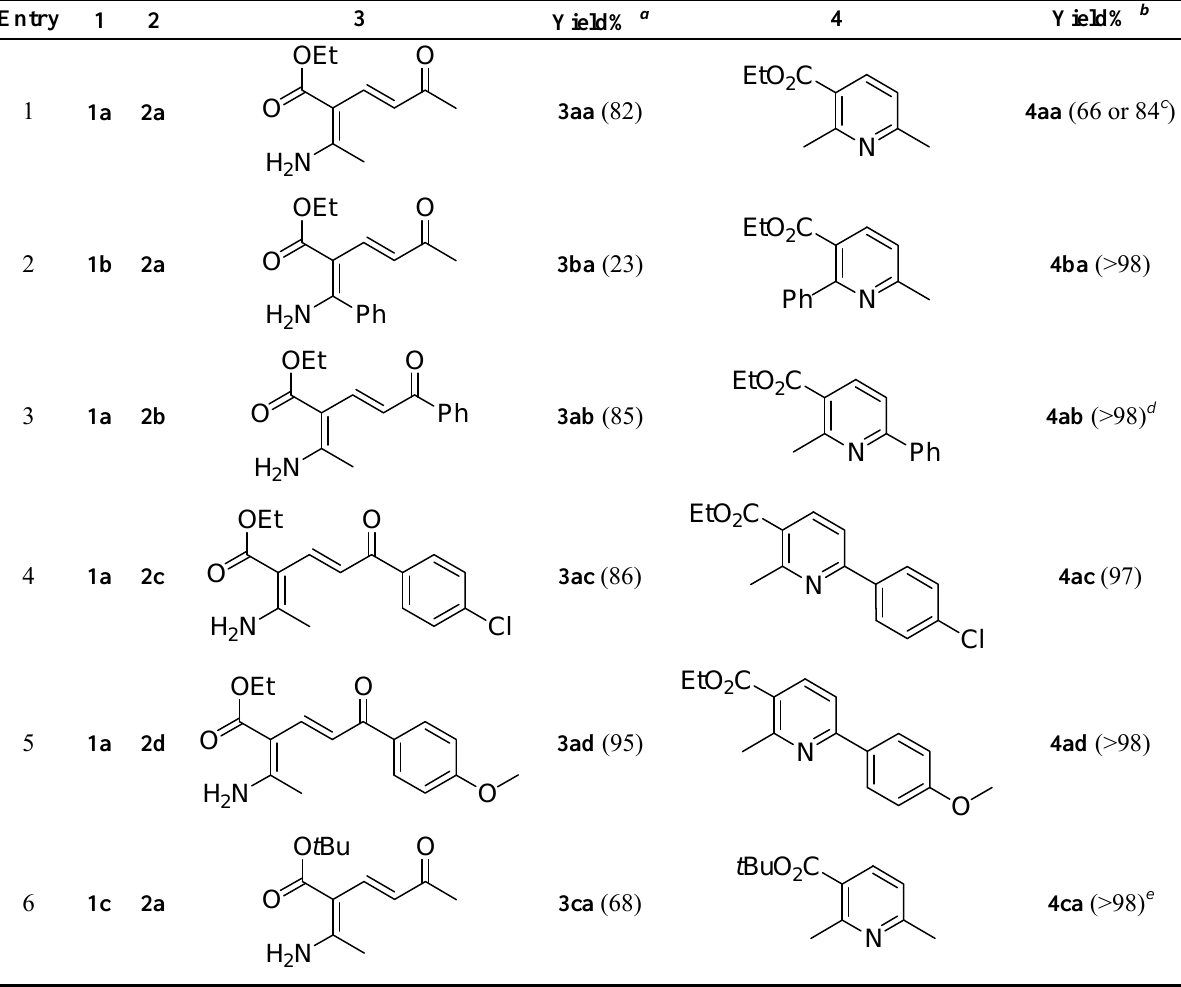
Table 1. Synthesis of aminodienones 3 and their cyclodehydration to pyridines 4 mediated by